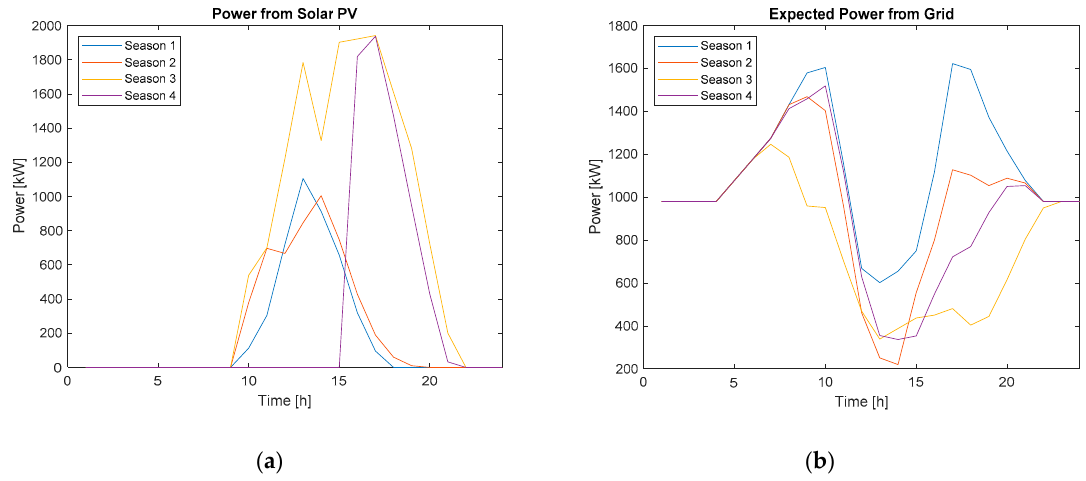
Figure 6. ( a ) Solar PV power from a 3671.53 kW System for one scenario; ( b ) expected power from the grid for solar PV and grid power case.